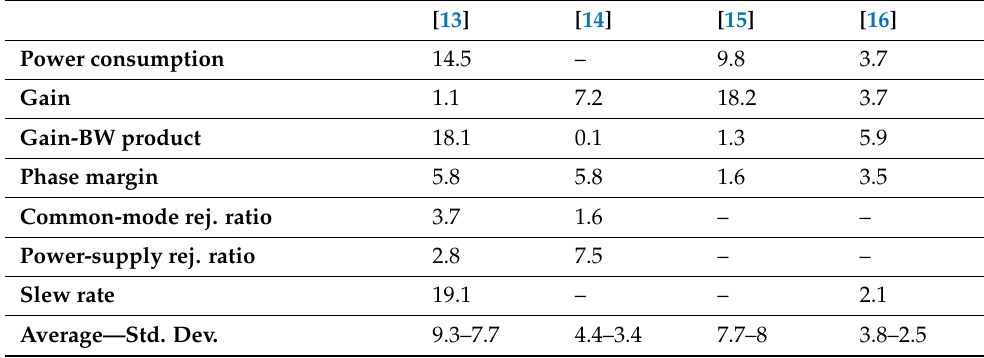
Table 4. Prediction error statistics in % per specification in prior state-of-the-art calculated using Equation (1).